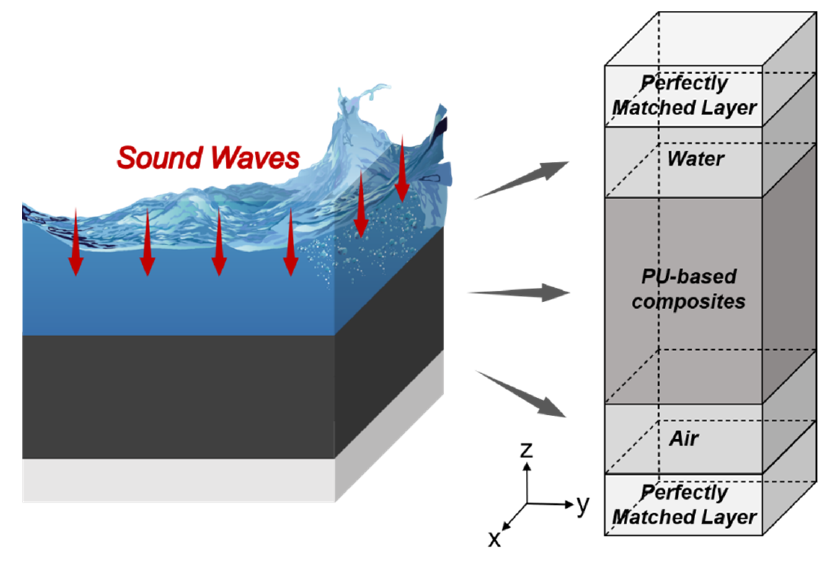
Figure 8. Schematic of the underwater sound absorption layer.